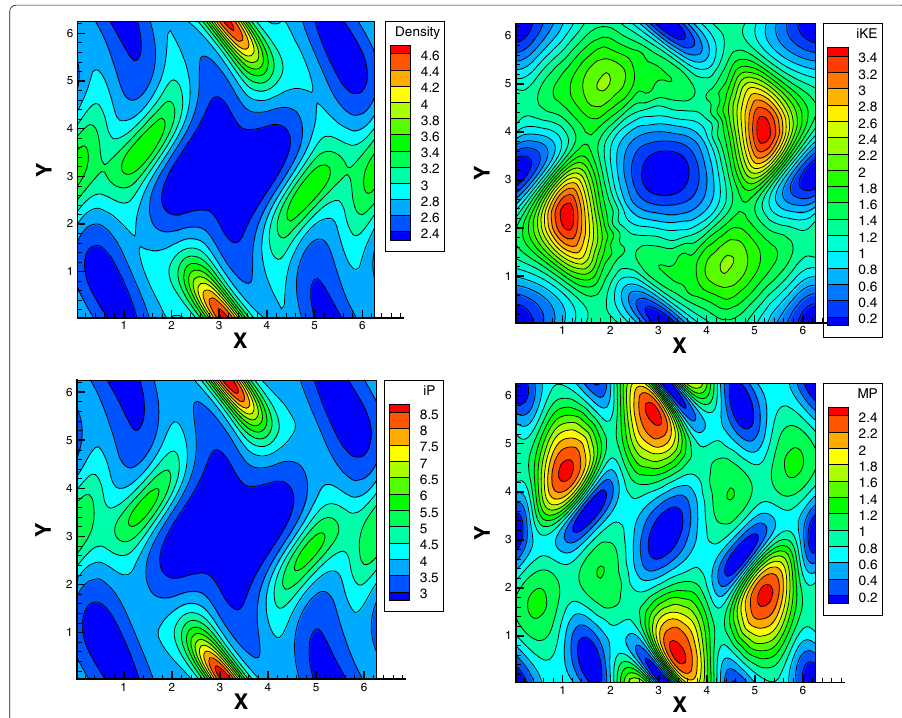
Fig. 13 The results of the multiscale Orszag-Tang vortex problem with Kn 10 4 and r 1. Contour lines show the UGKWP solutions and contour floods show the UGKS solutions